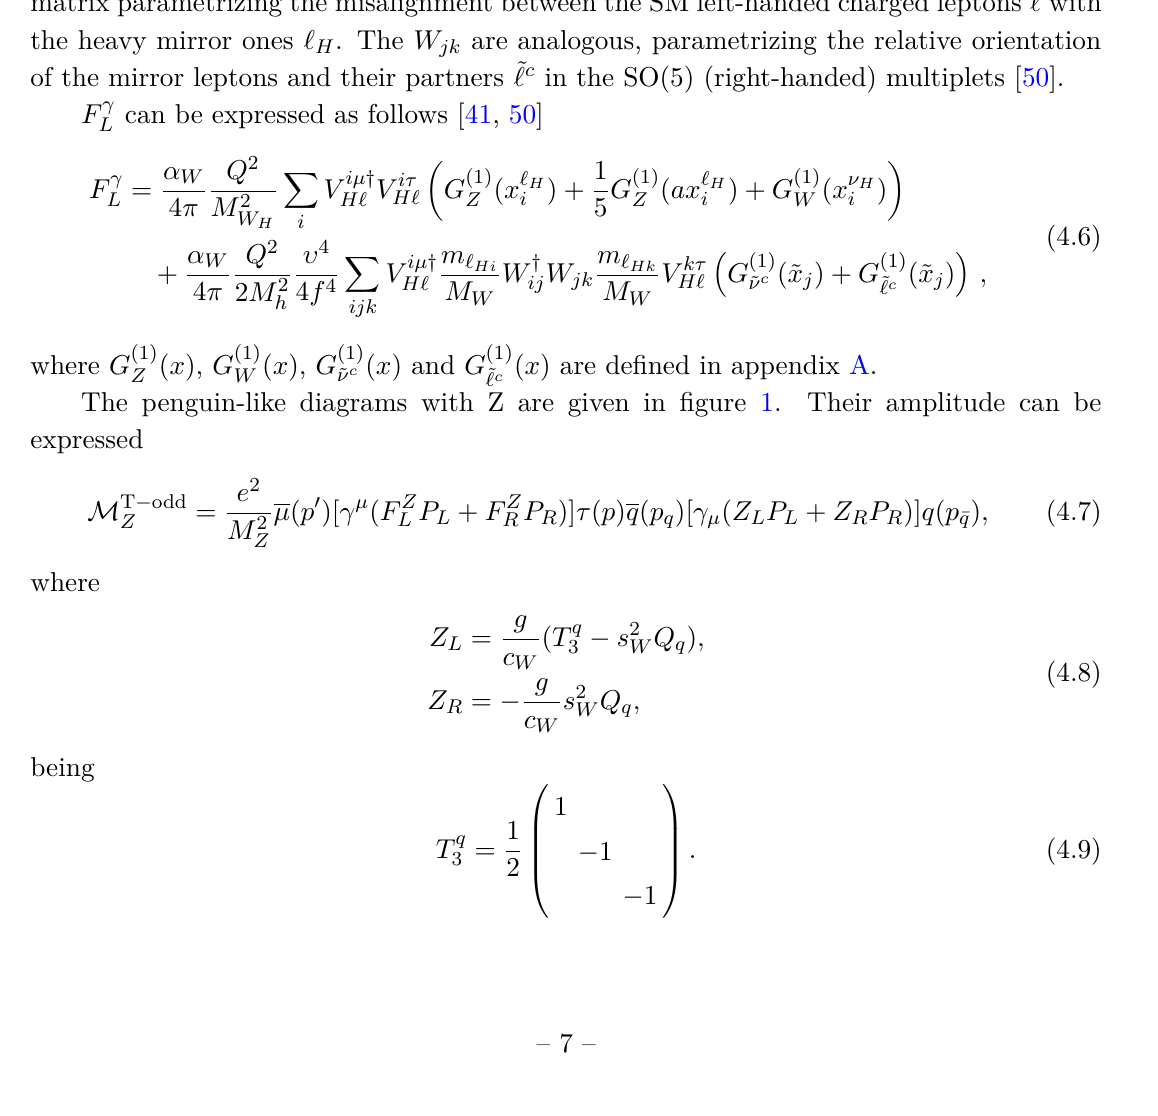
Figure 1 . Topologies of the diagrams that contribute to the processes γ, Z → 2 with a = M = 5 c 2 W WH ∼ 15 and we have used M 2 M 2 s 2 AH W